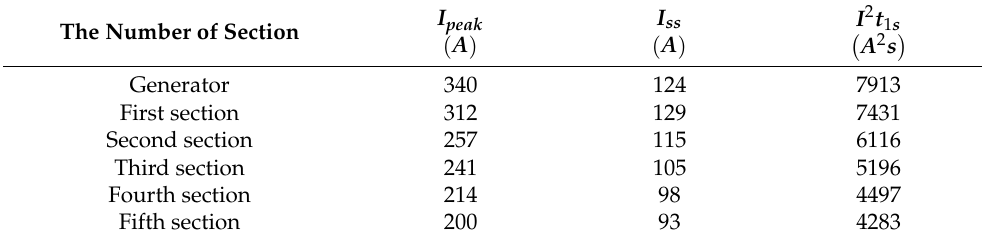
Table 4. The measured currents and Joule’s integral for different short-circuit places. The Number of